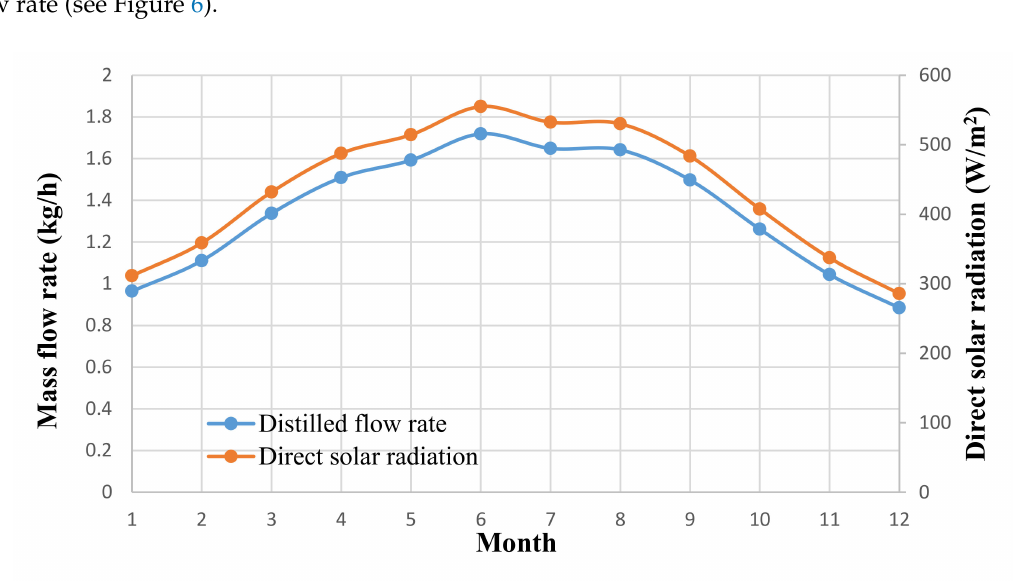
Figure 6. Freshwater production rate variation throughout the year according to a thermal e ffi ciency of 40% for the reference